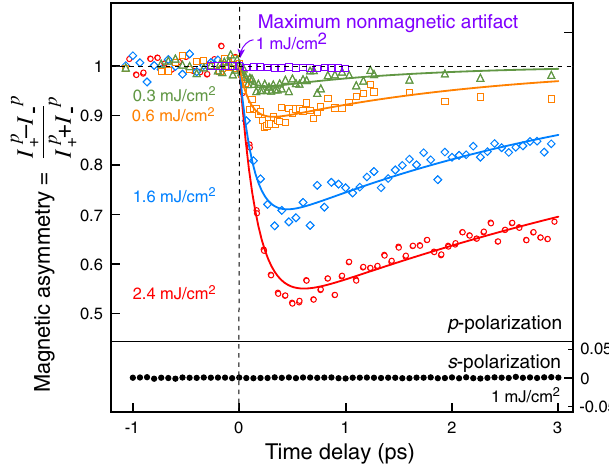
-1 0 1 2 3 Time delay (ps) FIG. 3. Pump-fluence-dependent demagnetization dynamics of Ni for the Ni-Fe grating. The magnetic asymmetry in Ni is measured by selecting XUV photon energies near the M 2 ; 3 absorption edges of Ni ( h(cid:1) ¼ 66 : 2 (cid:3) 0 : 2 eV ). By varying the amplitude.FIG. 2. (a) An alternating Ni-Fe grating sample geometry. pump laser fluence from 0.3 to 2 : 4 mJ = cm 2 , we can achieve up to edges after (b) Typical HHG spectra near the Fe and Ni M 2 ; 3 50% demagnetization. The demagnetization is linearly propor- reflection from the grating sample (blue curve). Magnetic asym- tional to the pump fluence. From the reflectivity data in Fig. 4, metry (brown curves) peaks at the expected locations of the Ni we estimate the maximum nonmagnetic contribution to the edges for various delay times (green line) and Fe (red line) M asymmetry signal by considering the variation of the real and 2 ; 3 before and after the arrival of the demagnetization laser pulse at imaginary reflective index, (cid:4) or (cid:5) (purple open squares, which the are on top of each other) during the first picosecond. The maximum nonmagnetic response is 2 orders of magnitude smaller than the demagnetization pump fluences between 0.3 and 2 : 4 mJ = cm 2 . The results of these measurements for both p -polarized (magnetic) and s -polarized (nonmagnetic) probes are shown in Fig. 3. The data for the p -polarized probe beam are fit to Þ ¼ a phenomenological exponential function: f ð t; t 0 1 (cid:1) (cid:1) A ð 1 (cid:1) e ð t (cid:1) t 0 Þ =(cid:7) M Þ e ð t (cid:1) t 0 Þ =(cid:7) R , where (cid:7) is demagnetiza- M is magnetization recovery time, (cid:1) A is de- tion time, (cid:7) R is the time zero of the magnetization amplitude, and t 0 dynamics, i.e., the delay time that results in maximum temporal overlap between pump and probe pulses. Both for the p -polarized pump are dependent on (cid:1) A and (cid:7) M pump fluence, spanning from (cid:1) A ¼ 5% to 50%, while the ¼ 90 (cid:3) 72 to 150 (cid:3) demagnetization time varies from (cid:7) M 19 fs . From these fits, we find that (cid:1) A is linearly propor- tional to fluence. The signal-to-noise ratio is the smallest at low pump fluence, where the demagnetization amplitude approaches the noise level of 3.5%.